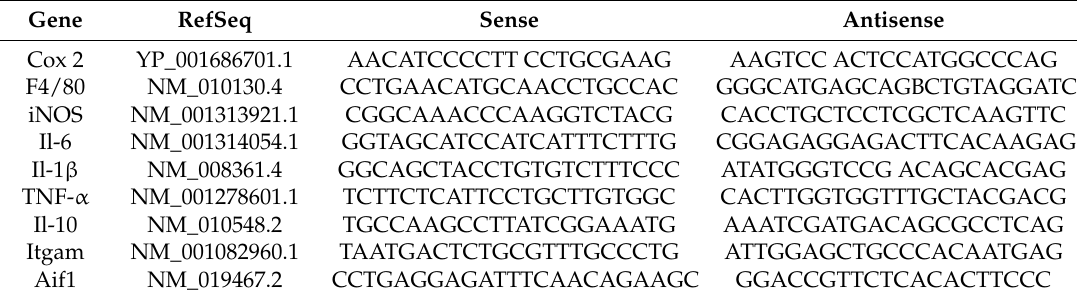
Table 1. Primer sequences of real time